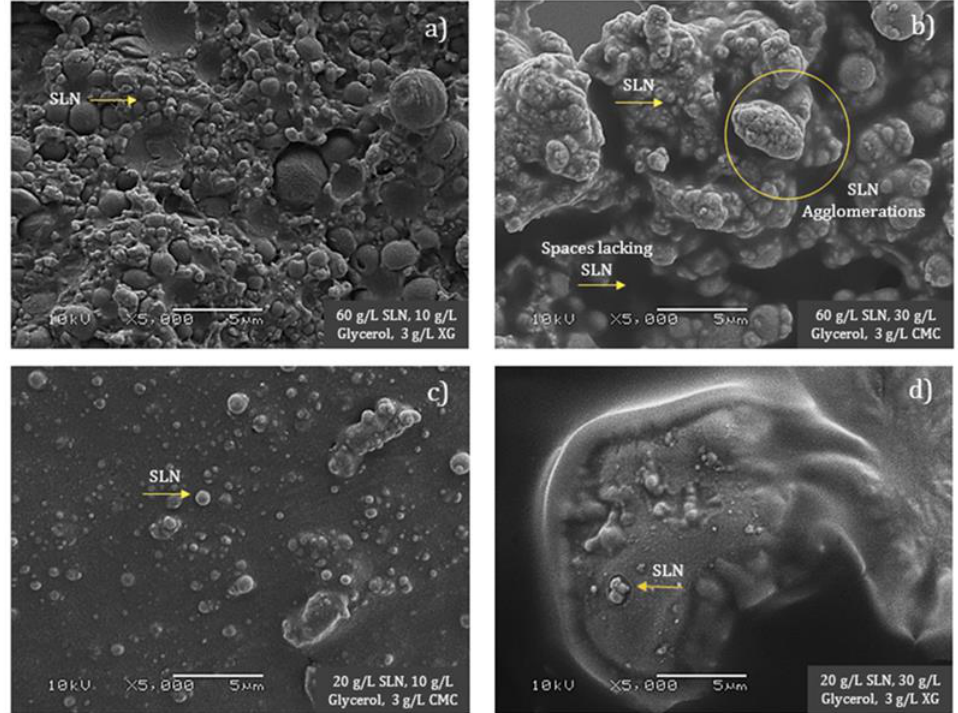
Figure 3. Microscopic surfaces of edible films prepared with 60 g/L of SLN, 10 g/L of glycerol, XG ( a ); 60 g/L of SLN, 30 g/L of glycerol, CMC ( b ); 20 g/L of SLN, 10 g/L of glycerol, CMC ( c ); and 20 g/L of SLN, 30 g/L of glycerol, XG ( d ).